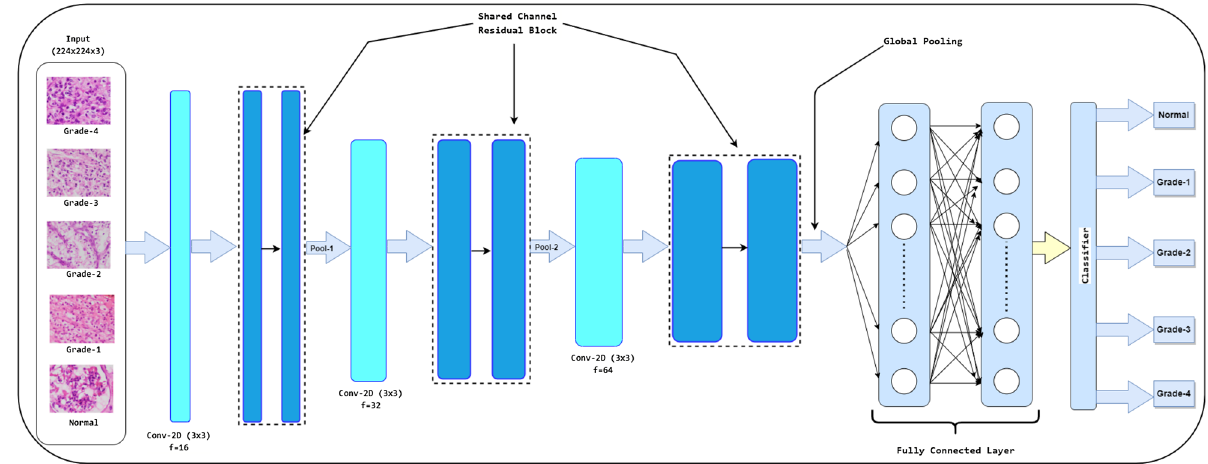
Figure 2. Structure of the proposed RCCGNet for grading of renal cell carcinoma from kidney histopathology